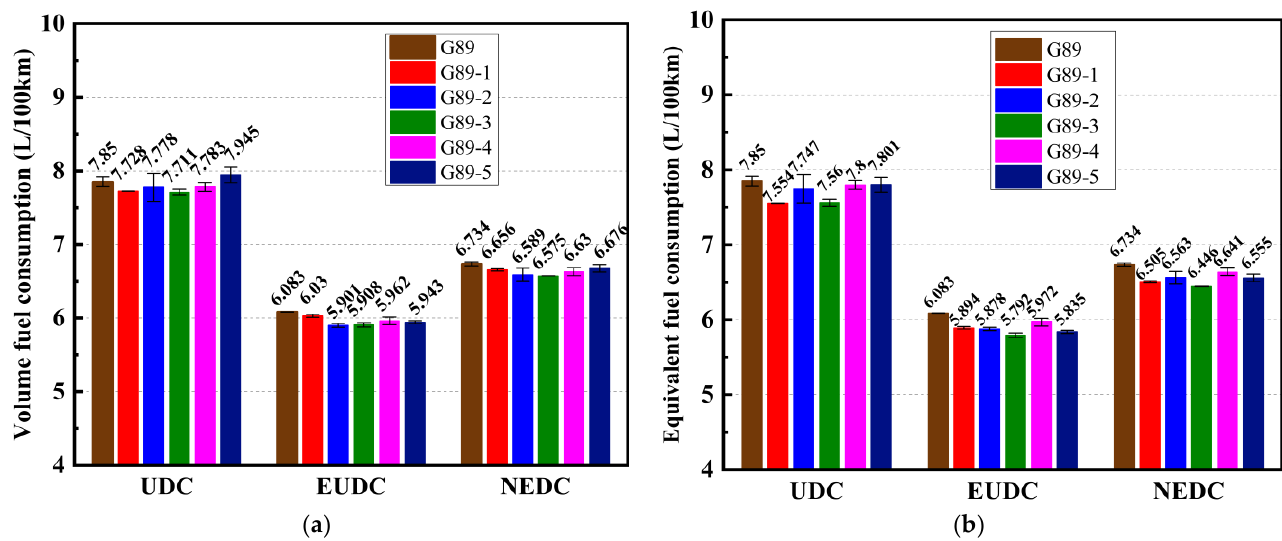
Figure 3. The volume fuel consumption and equivalent fuel consumption of the PFI vehicle when fueled with the different fuels: ( a ) the volume fuel consumption; ( b ) the equivalent fuel consumption.